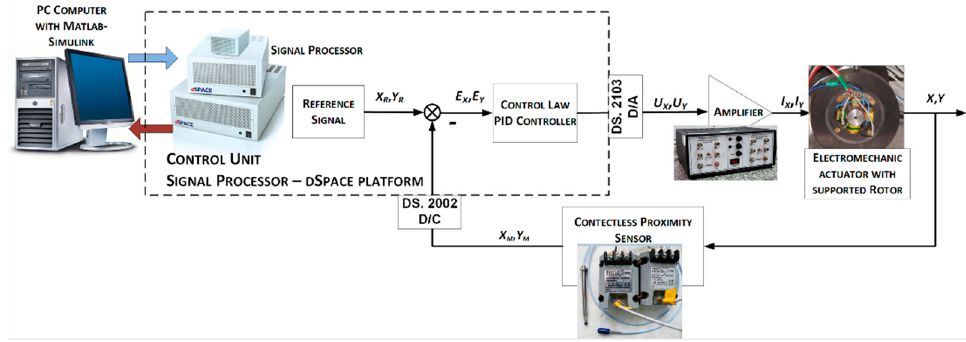
Figure 5. Active magnetic bearing control system.